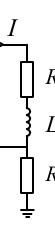
Figure 2. Schematic diagram of the driving circuit.